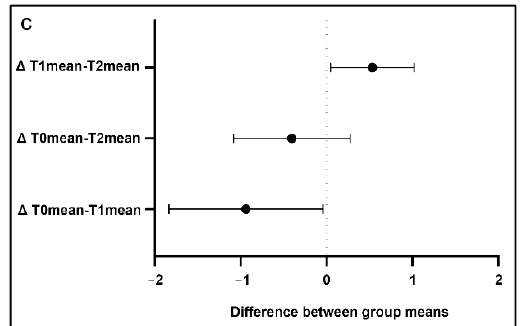
Figure 2. Maximum ( A ), minimum ( B ) and mean ( C ) temperature differences in the areas: the intersection with the dotted line identifies “not statistical significance”. The mean temperature differences T0–T1 and T1–T2 are significant ( C ). Δ = temperature difference in °C.